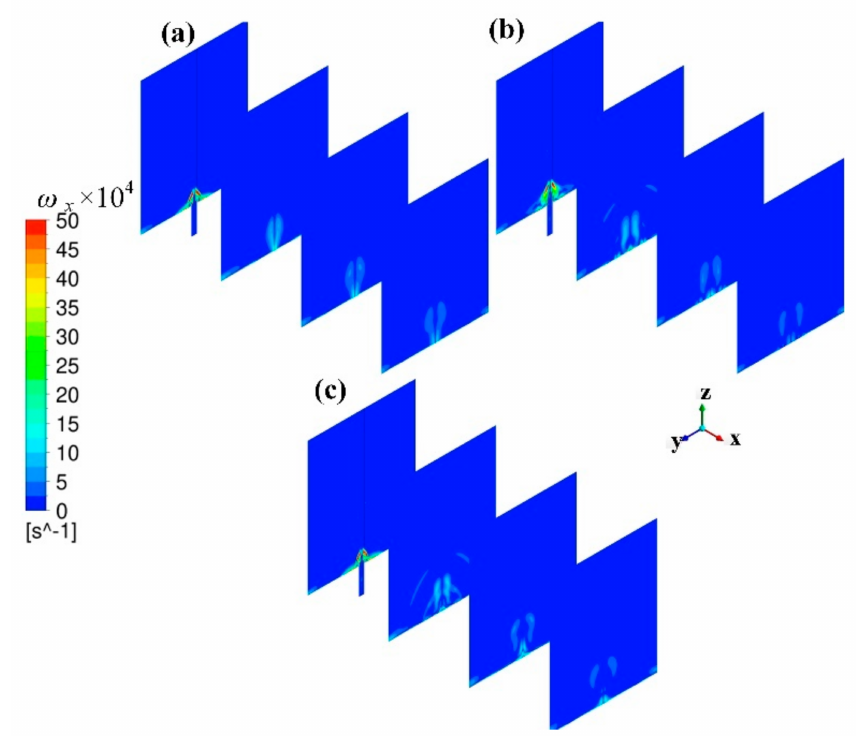
Figure 20. Intensity of the streamwise vortexes at x = 0, 30, 60, and 90 mm for ( a ) Case a, ( b ) Case b, and ( c ) Case c.